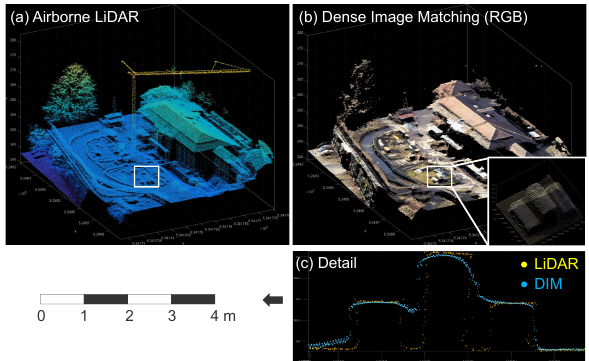
Figure 2. Penetration depths of LiDAR and DIM over different surfaces, (a) RGB-colored DIM point cloud featuring different surface types (white boxes), (b) color coded height differences LiDAR minus DIM, (c) vertical section of profile AB